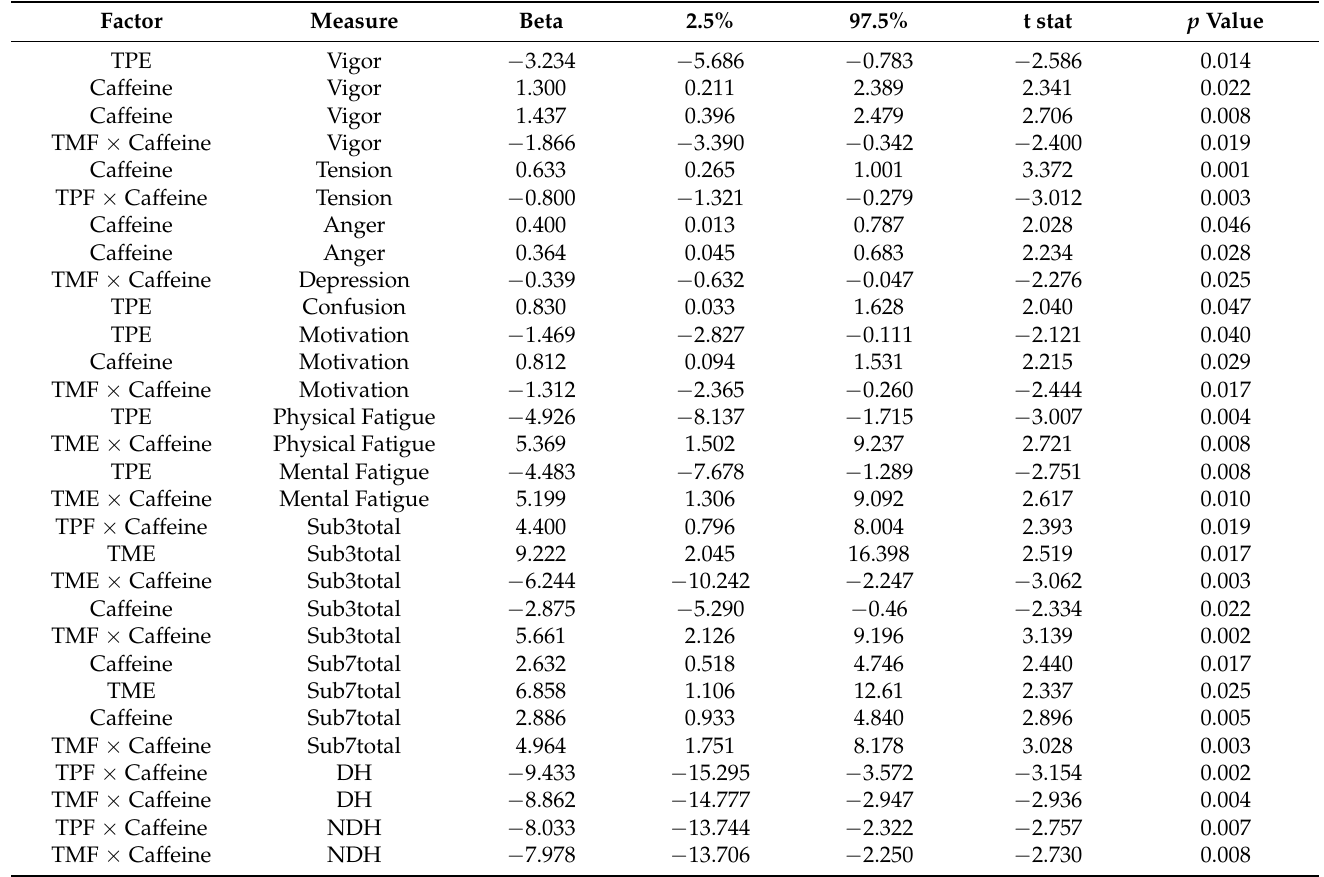
Table 2. Trait and caffeine influence on moods, cognitive tasks and fine motor tasks (significant relationships only). Factor